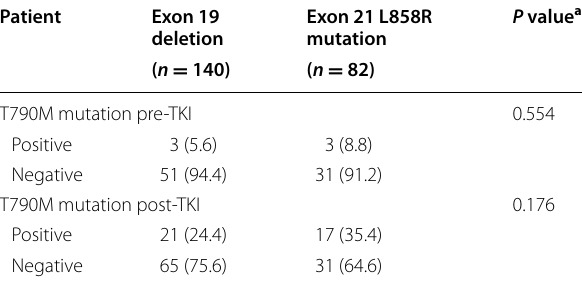
a By using χ 2 test. All values are presented as the number of patients followed by the percentage in the